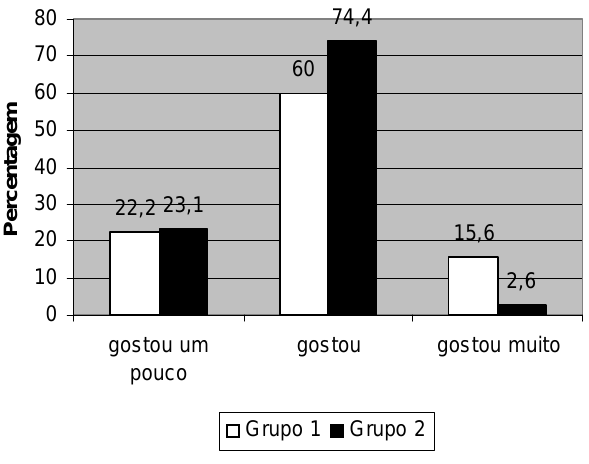
Figura 1. Percentagem de alunos que “gostaram um